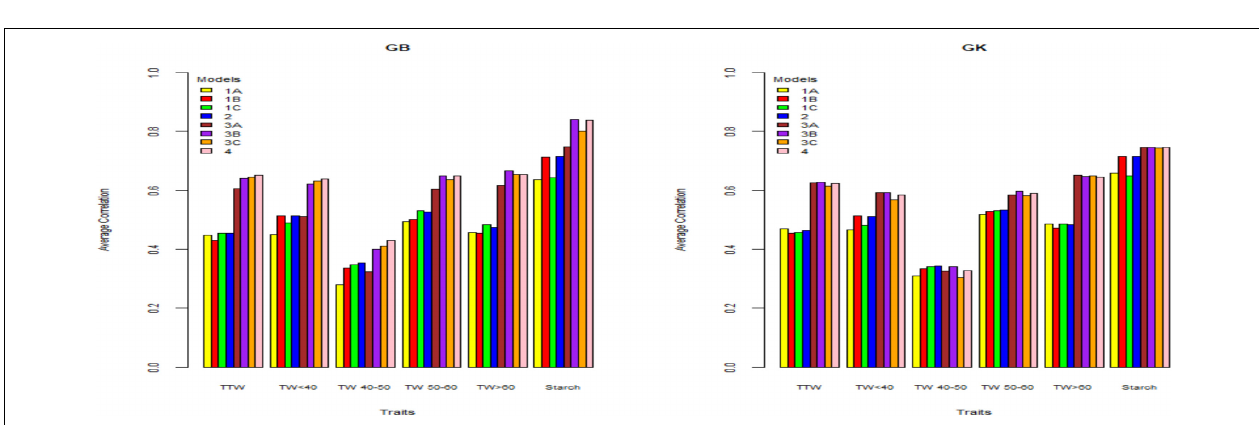
FIGURE 3 | Genome-based predictions (average correlation between observed and predicted values) of potato cultivars in Umeå site for total tuber weight (TTW), tuber weight with size below 40 mm (TW < 40), tuber weight with 40–50 mm size (TW 40–50), tuber weight with 50–60 mm size (TW 50–60), tuber weight above 60 mm size (TW > 60), and tuber starch percentage (Starch) considering single environment pseudo-diploid (A) (model 1) (1A), additive tetrasomic polyploid (B) (model 1) (1B), full tetraploid (C) (model 1) (1C), and B-C (model 2) (2) and multi-environment pseudo-diploid (A) (model 3) (3A), additive tetrasomic polyploid (B) (model 3) (3B), full tetraploid (C) (model 3) (3C), and B-C (model 4). These models (1–4) with marker matrices A, B, and C (1A, 1B, 1C, 2, 3A, 3B, 3C, and 4) were combined with linear kernel GB (GBLUP) and non-linear kernel GK (Gaussian